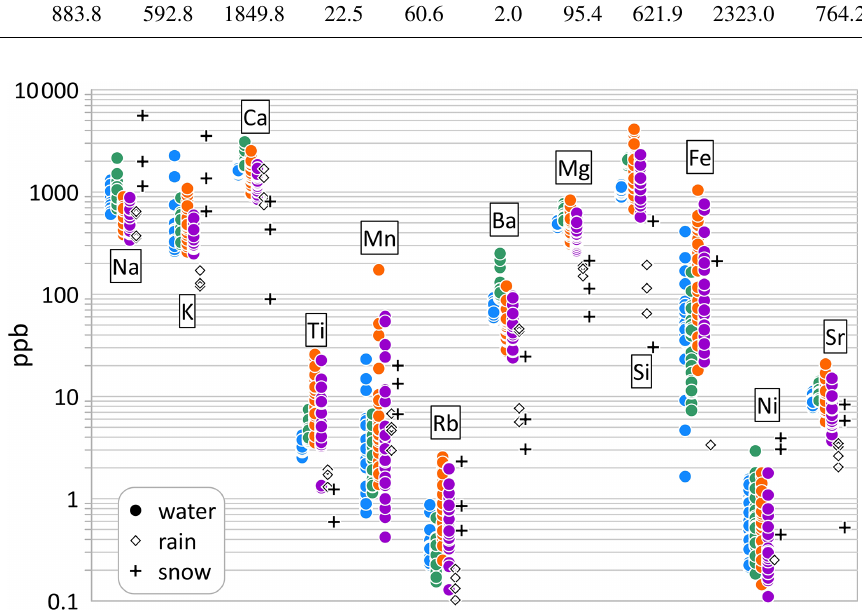
Figure 9. Abundances of detectable elements in the time series of water samples, along with the rain and snow samples. Water samples are presented from left to right with the same color designations as previous figures: blue = Stream, green = Spring, orange = RG-1, and purple = RG-2. Note the logarithmic scale on the y